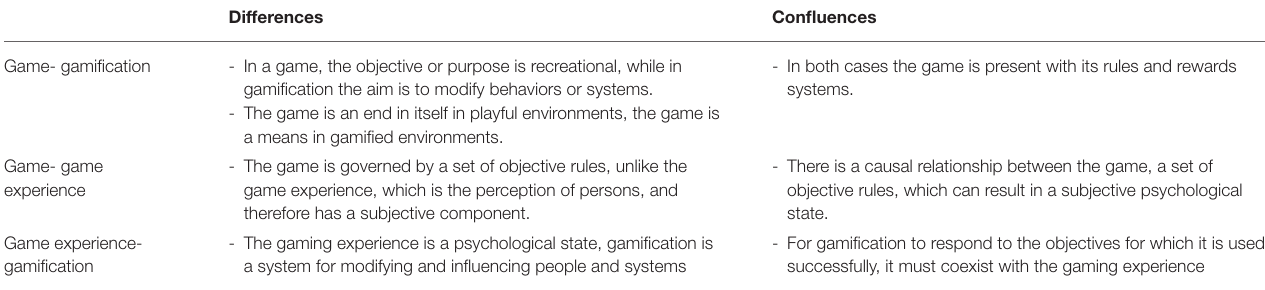
TABLE 5 | Differences and confluences between game, game experience and gamification.